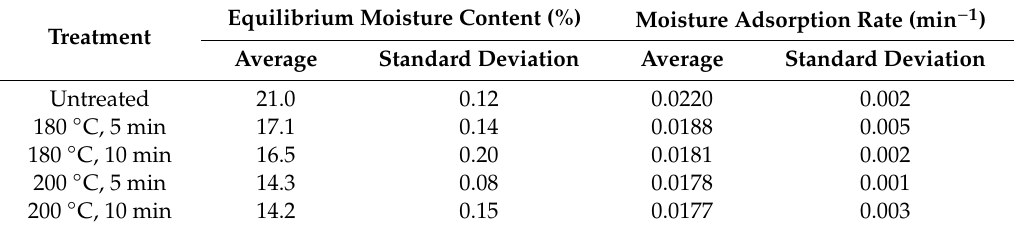
Table 2. Equilibrium moisture content and moisture adsorption constant of pellets made from untreated and steam treated straws in the controlled chamber set at 30 ◦ C and 90% relative humidity.